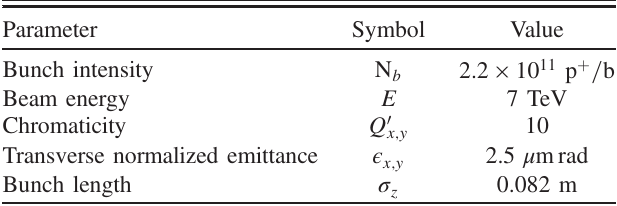
TABLE II. Main machine and simulation parameters used for the HL-LHC studies with P y HEADTAIL .